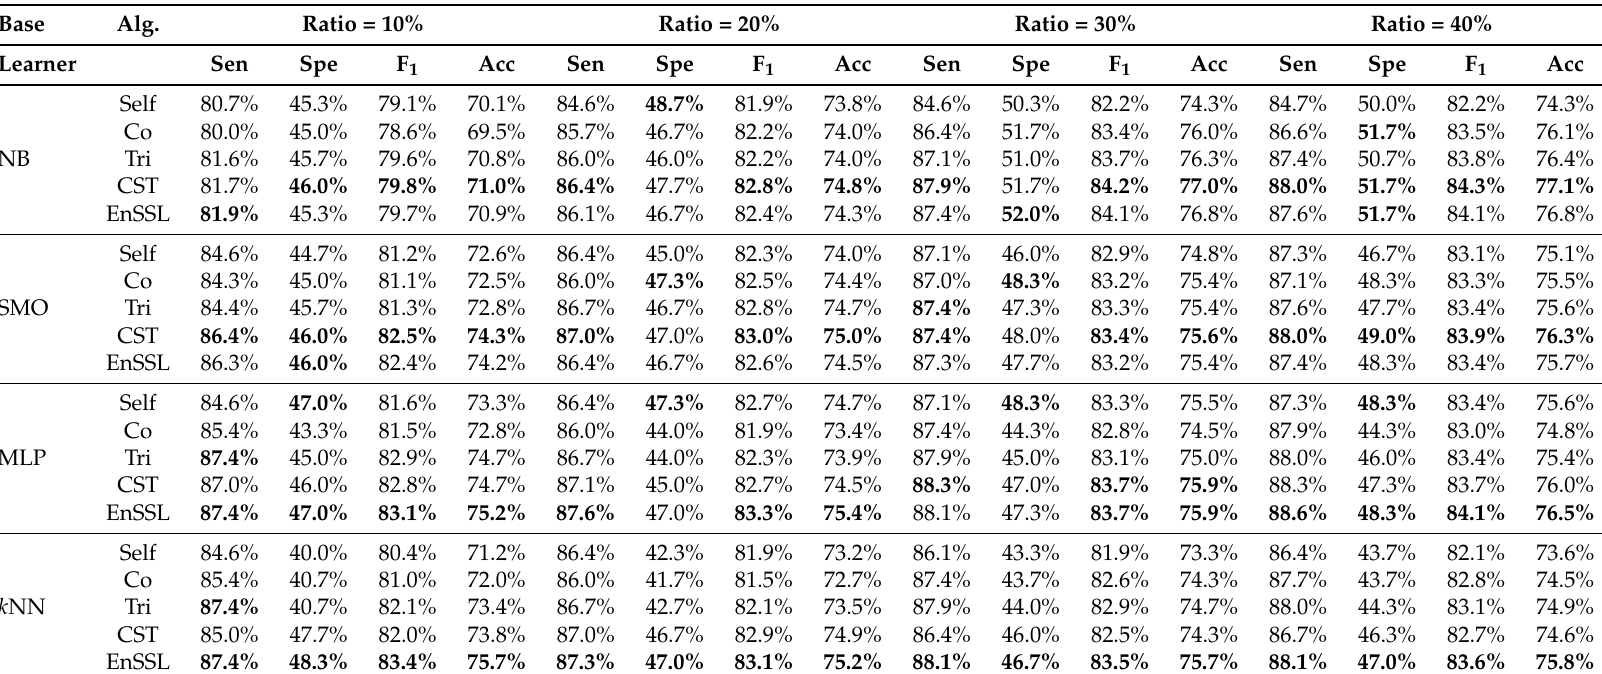
Table 4. Performance evaluation of Self-training, Co-training, Tri-training, CST-Voting and EnSSL on the German credit